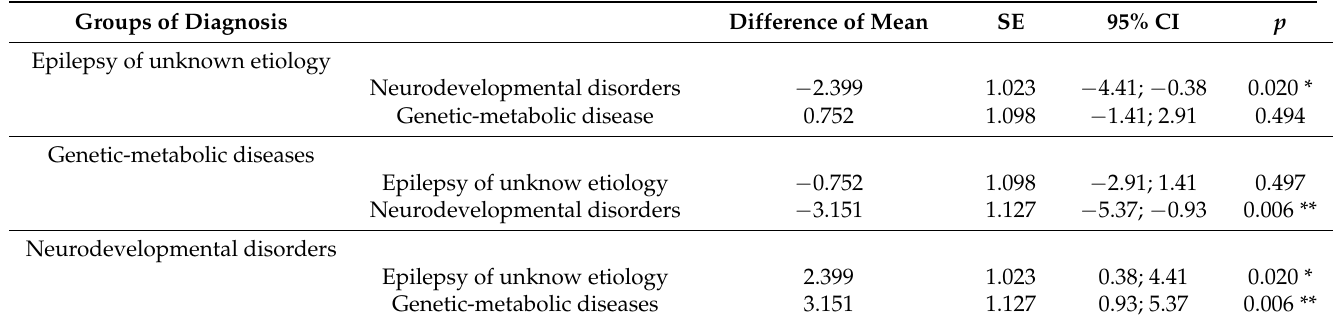
Table 2. Multiple comparisons of the Perceived Stress Scale mean scores (post-hoc